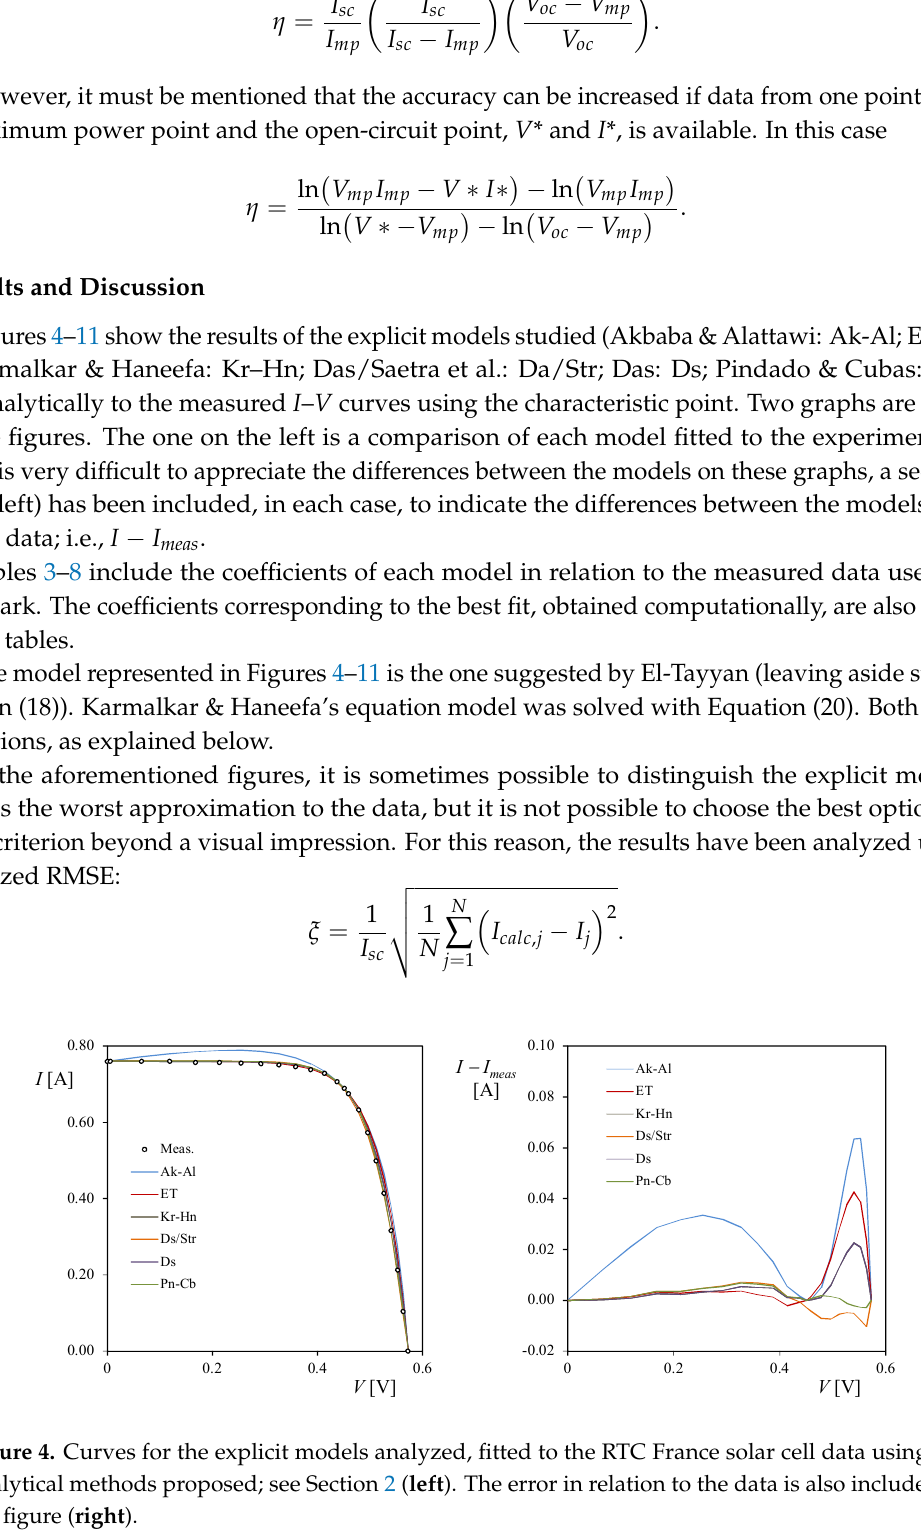
Figure 5. Curves for the explicit models analyzed, fitted to the TNJ Spectrolab solar cell data using the analytical methods proposed; see Section 2 ( left ). The error in relation to the data is also included in the figure ( right ).